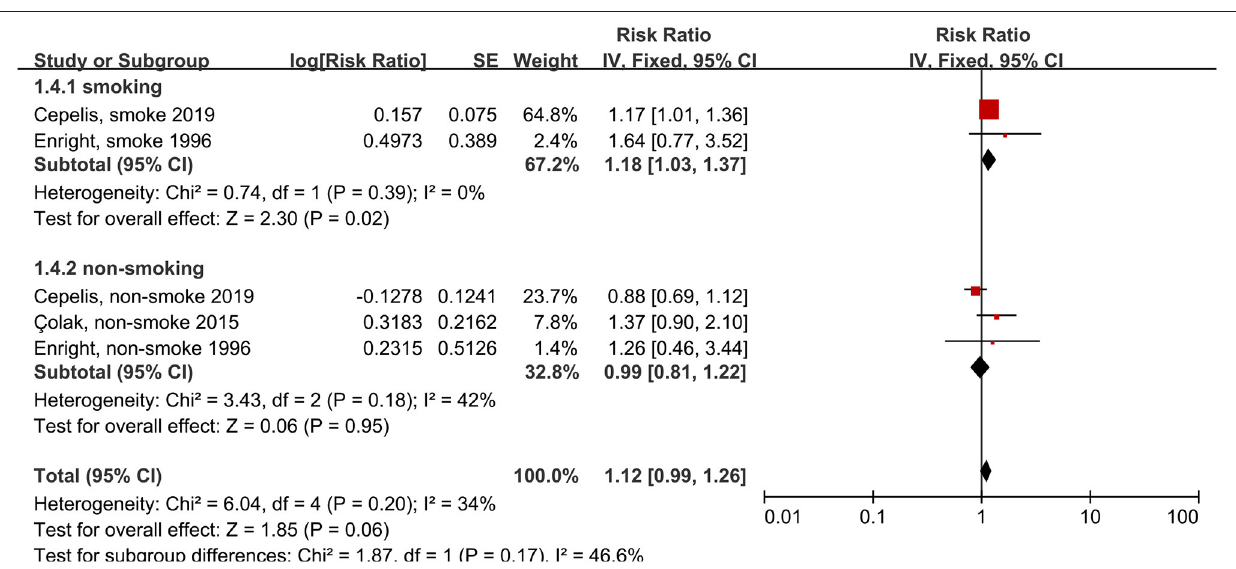
Frontiers in Neurology |